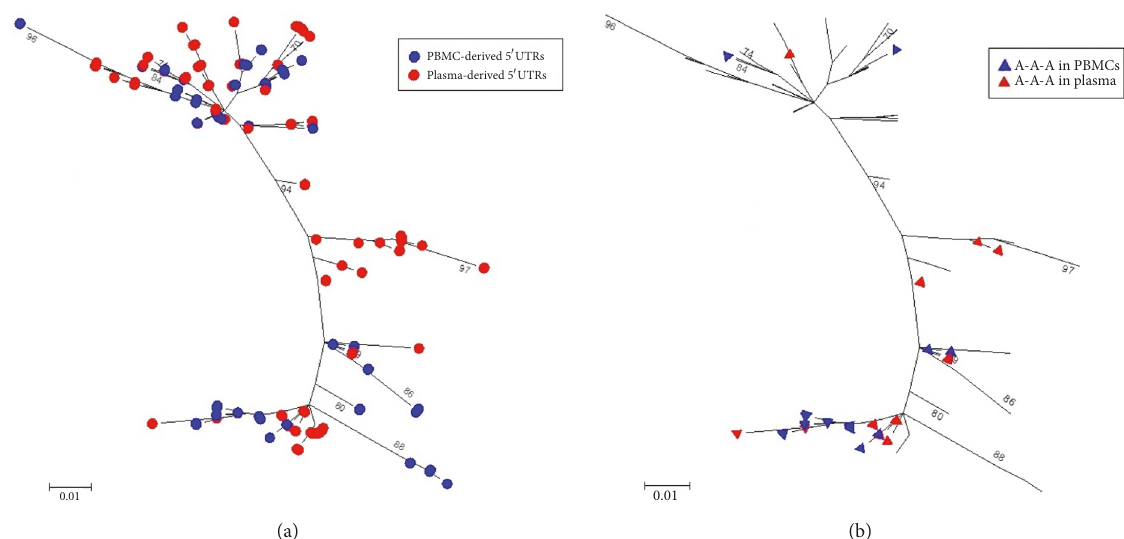
Figure 4: Phylogenetic tree analysis of all PBMC- and plasma-derived HCV IRES sequences. The evolutionary history was inferred by using the Maximum Likelihood method based on the Kimura 2-parameter model. The tree with the highest log likelihood (-1129.7196) is shown. Initial tree(s) for the heuristic search were obtained by applying the Neighbor-Joining method to a matrix of pairwise distances estimated using the Maximum Composite Likelihood (MCL) approach. The tree is drawn to scale, with branch lengths measured in the number of substitutions per site. The analysis involved 450 nucleotide sequences. PBMC-derived HCV IRES nucleotide sequences (n=225; coloured in blue) and plasma-derived HCV IRES nucleotide sequences (n=225; coloured in red) (a). HCV IRESes with the triple adenine variant (A-A-A) in PBMC (n=36; blue triangles) and in plasma (n=26; red triangles) (b). All positions containing gaps and missing data were eliminated. There were a total of 200 positions (nt 100 to 300) in the final dataset. The bootstrap values along the branches indicate percent confidence of branches. Bootstrap values greater than 70% are shown. The scale bar corresponds to 0.01 substitutions per site. Evolutionary analyses were conducted in